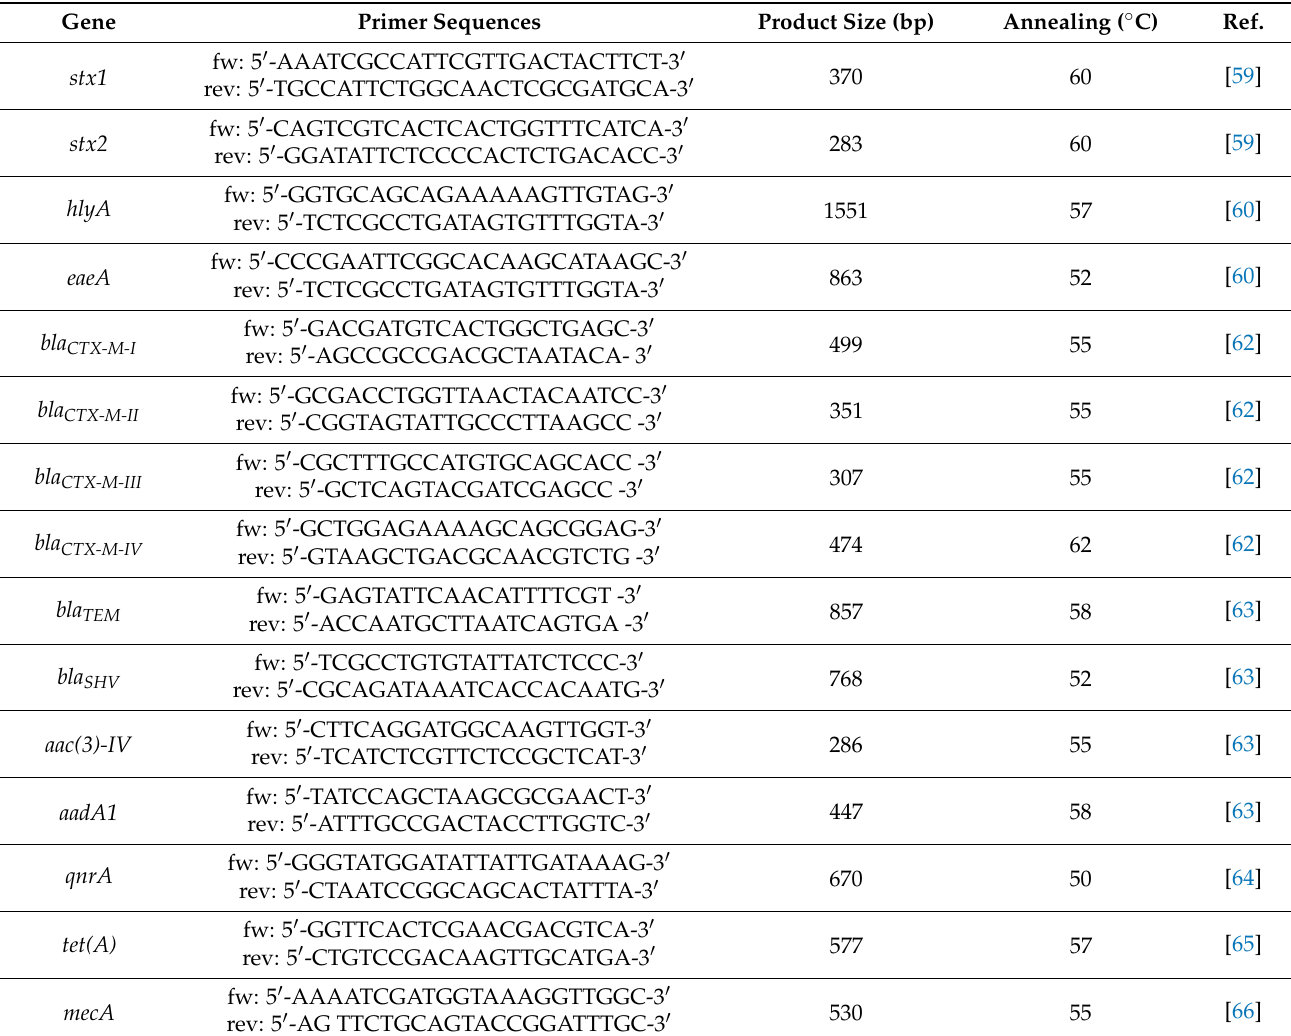
Table 4. Primers, product size, and annealing temperatures used for virulence and antimicrobial resistance genes identifica- tion in the present